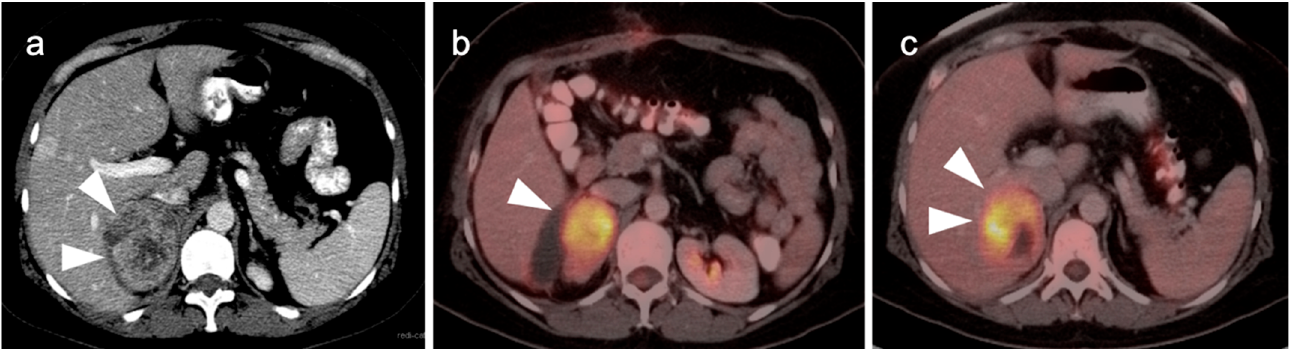
Figure 24. Adrenal cortical carcinoma. ( a ) A preoperative axial contrast-enhanced CT shows a heterogeneously enhancing right adrenal mass with areas of necrosis which was an adrenal cortical carcinoma at pathology; ( b , c ) Axial fused images from an FDG PET-CT scan performed 7 months following resection of the adrenal cortical carcinoma showing a recurrent hypermetabolic mass in the right adrenal fossa (( b , c ), white arrowheads), with the suggestion of possible invasion into the adjacent liver, with an indistinct plane between the mass and the liver (white arrowheads, ( c )).